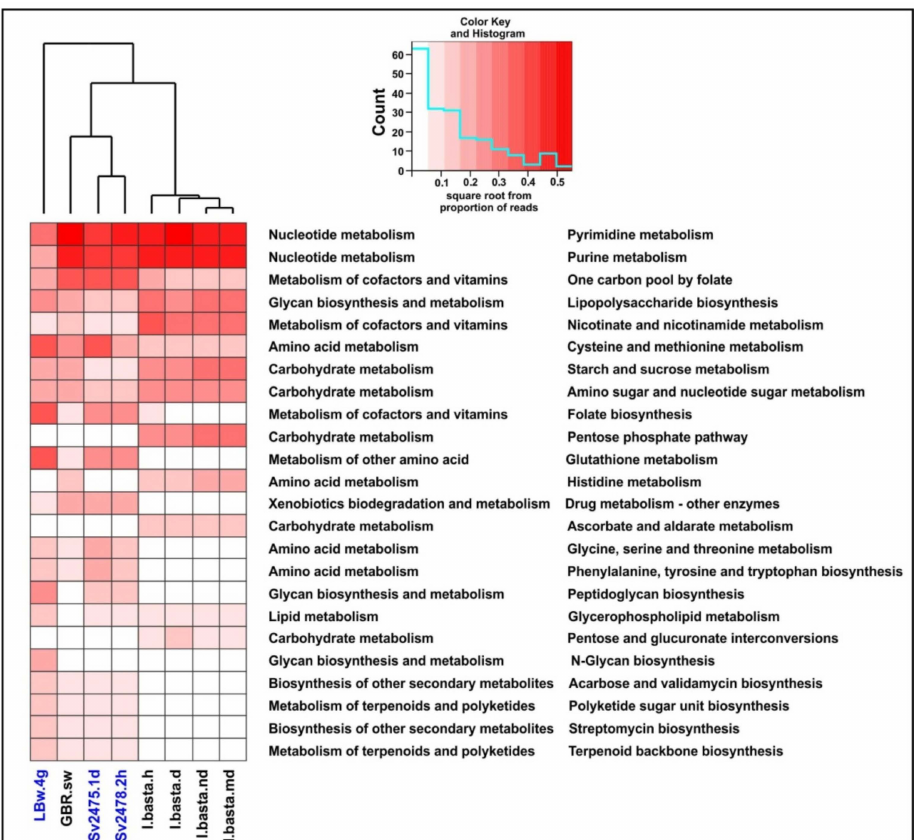
Figure 4. Dominant metabolic functions defined in marine and freshwater virome datasets. The Baikal samples are highlighted in